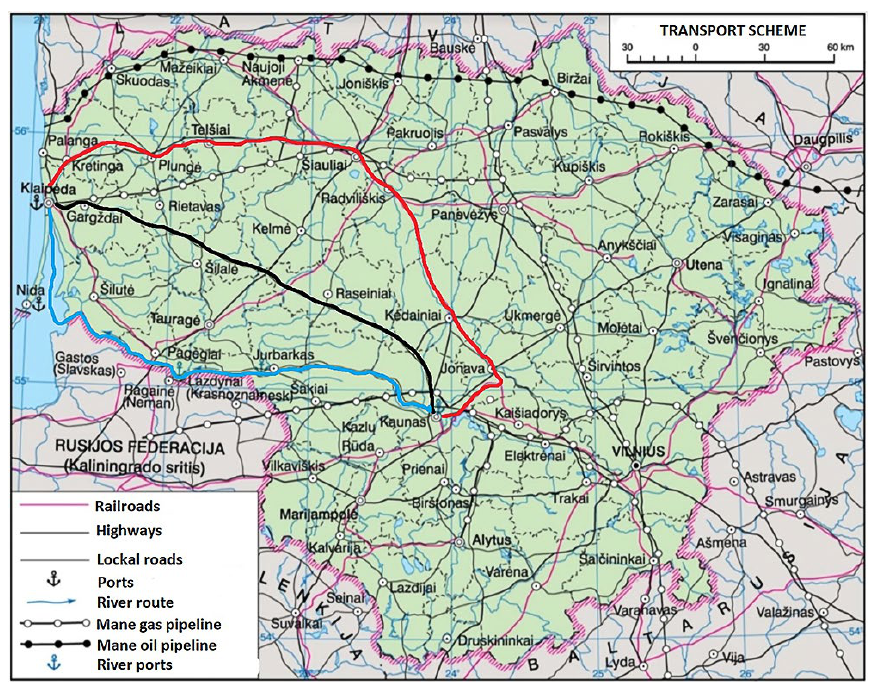
Figure 3. Road, railway and inland waterway transport system between Klaipeda port and Kaunas free economic zone (https://www.vle.lt/straipsnis/lietuvos-transportas/, accessed on 3 September 2022) [27].